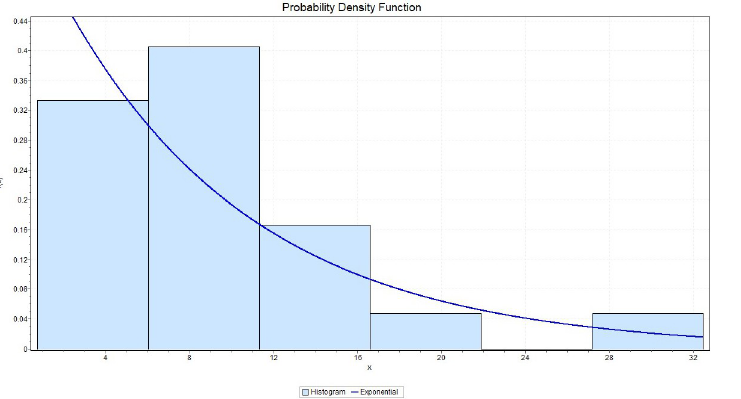
Fig 1. The histogram of the data set and its fitted density function to X.